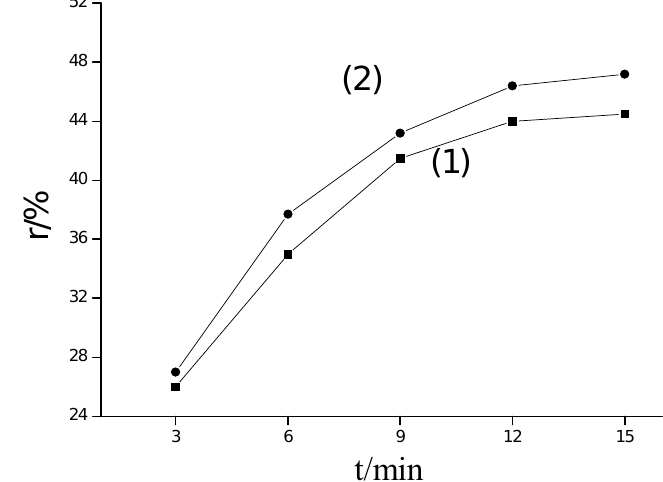
Figure 1. Effect of desulfurization to thiophene and DBT in model fuel with IL.